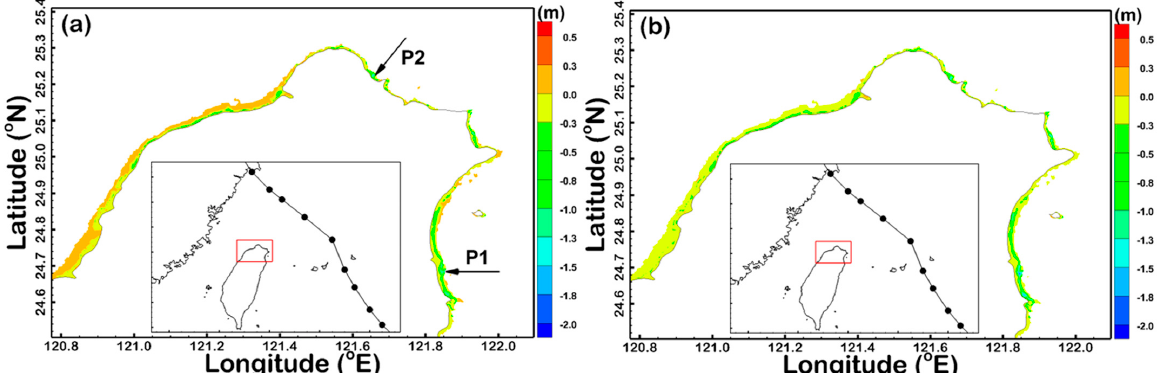
Figure 11. Spatial distribution of the difference in the maximum SWH between the scenarios of ( a ) S_NO1 and S_NO2 and ( b ) S_NO1 and S_NO3 during the passage of Super Typhoon Lekima in 2019. The areas with water depths greater than − 20 m are shown.